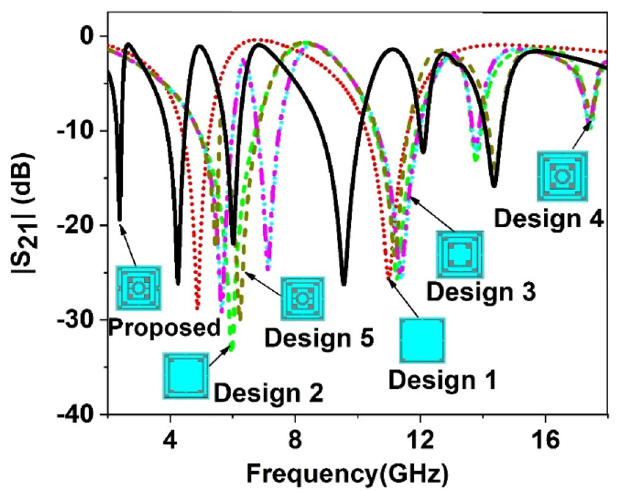
Figure 3. Change of |S 21 | for various design steps.